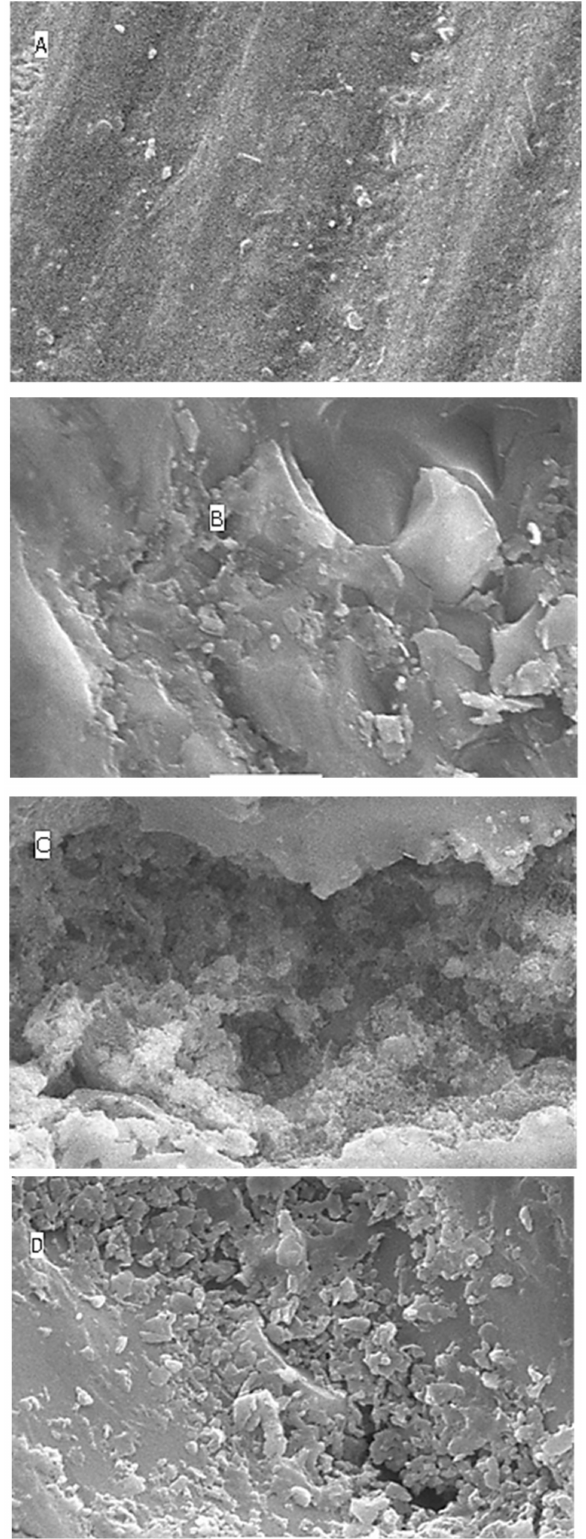
Figure 7. SEM images ( A – D ) of surface roughness at baseline, 24 h, 96 h and 168 h in 4% acetic